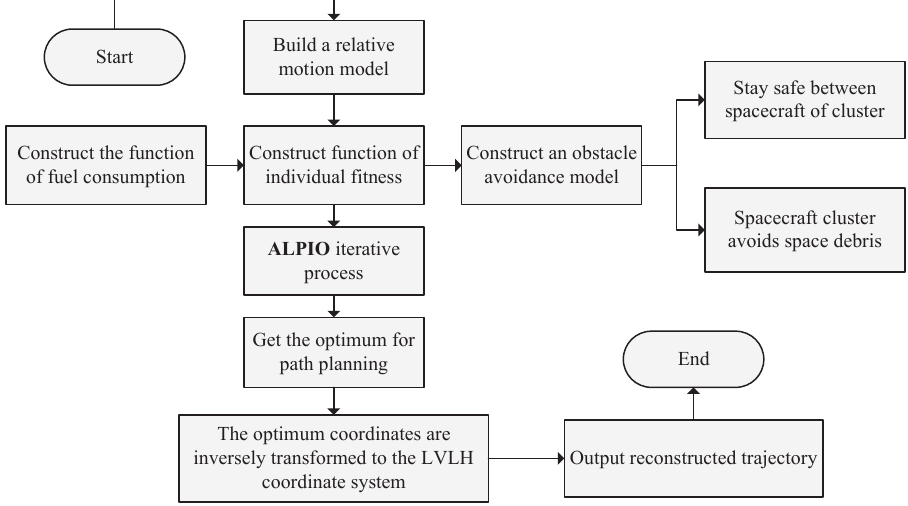
Figure 9. Flow chart of ALPIO for planning orbit